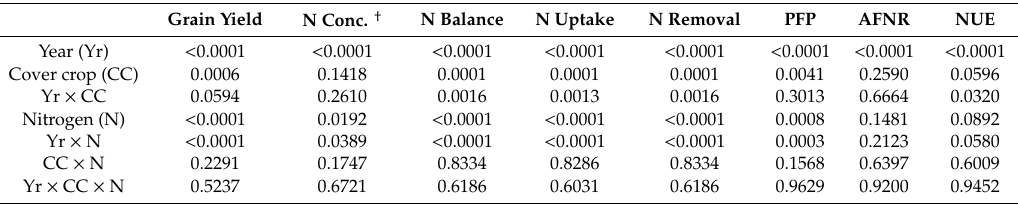
Table 1. E ff ect ( p -values) of year, cover crop, and nitrogen rate on corn grain yield, N concentration, N balance, N uptake, N removal, partial factor productivity (PFP), apparent N fertilizer recovery (ANFR), and N use e ffi ciency